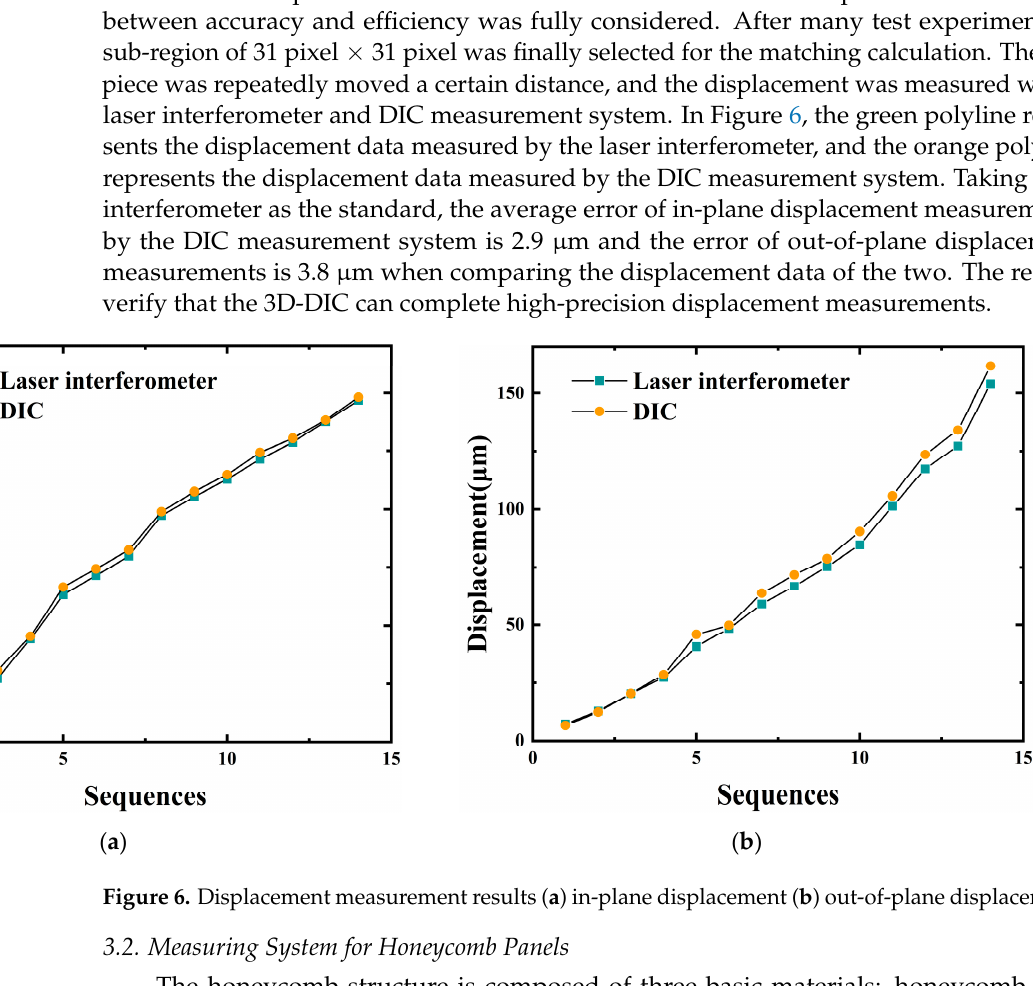
Figure 5. Displacement test system ( a ) in-plane displacement ( b ) out of plane displacement.